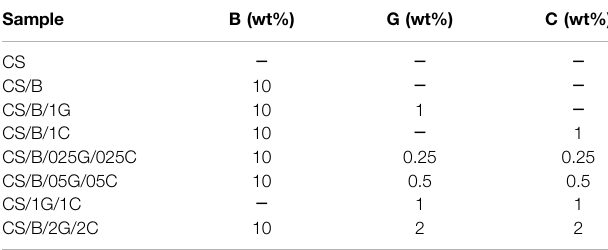
TABLE1| Sampleformulationsintermsofborax(B),GO(G),andCNC(C)content (wt%).